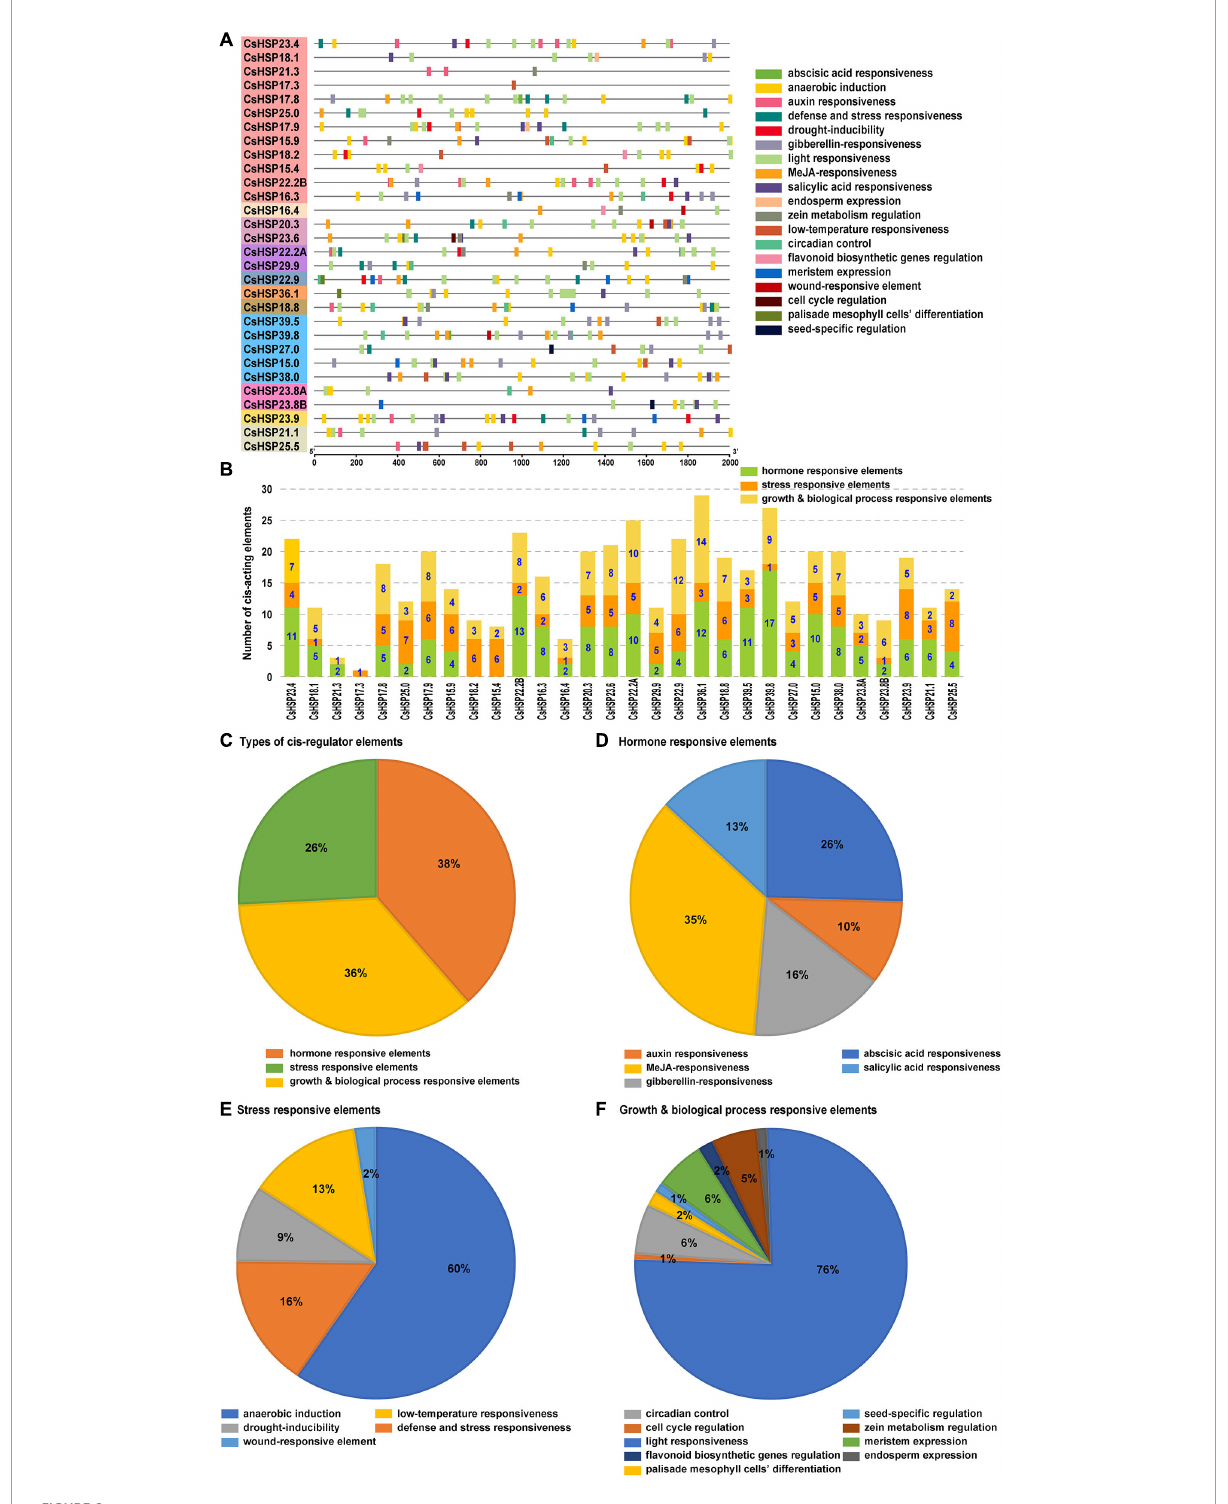
FIGURE6 Statistical summary and distribution of cis -elements. (A) Cis -element distributions in the putative promoters of CsHSP20s . (B) The number of three kinds of cis -elements in the promoters of each CsHSP20 gene. (C) The relative proportions of three kinds of cis -elements. (D–F) The detailed percentages of each type of cis